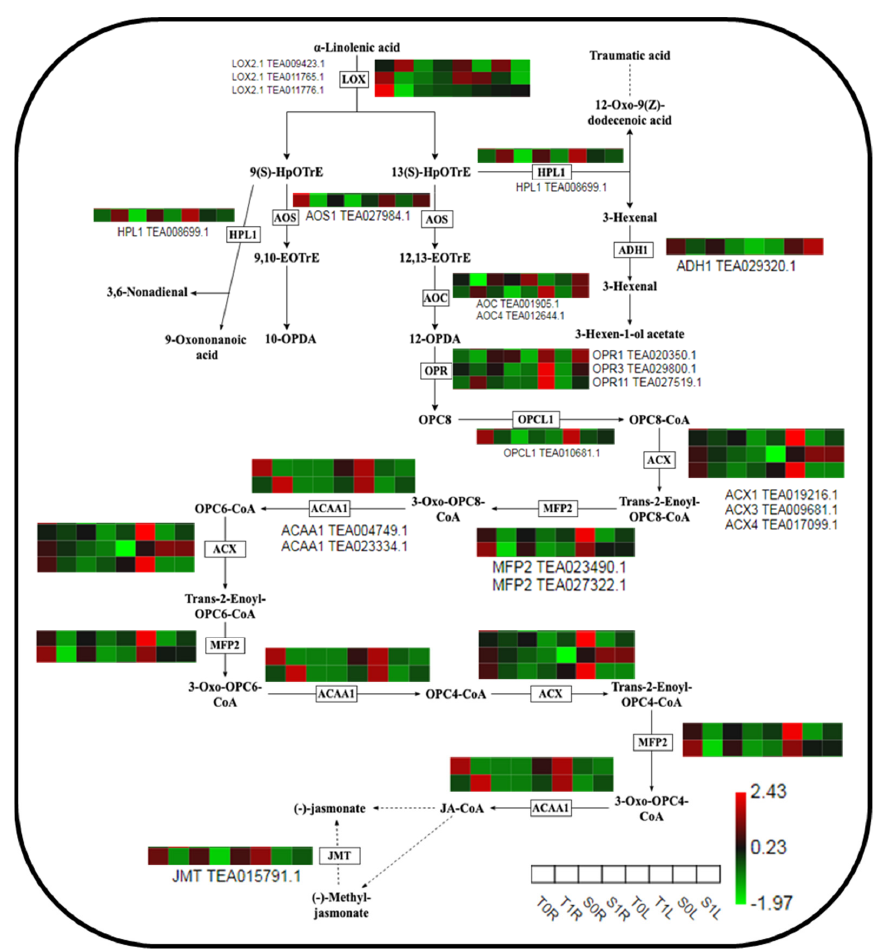
Figure 5. Differential protein expression pattern in the α -linolenic acid metabolism pathway in the roots and leaves of Tieguanyin and Shuixian under La treatment. T0L, Tieguanyin leaf under the control treatment; T1L, Tieguanyin leaf treated with 1.2 mmol/L La; S0L, Shuixian leaf under the control treatment; S1L, Shuixian leaf treated with 1.2 mmol/L La; T0R, Tieguanyin roots under the control treatment; T1R, Tieguanyin roots treated with 1.2 mmol/L La; S0R, Shuixian roots under the control treatment; S1R, Shuixian roots treated with 1.2 mmol/L La.